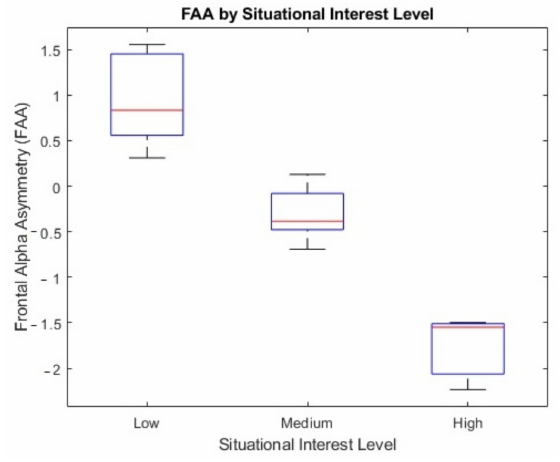
Figure 9. Box plot of FAA metric for the low, medium, and high SI student groups.